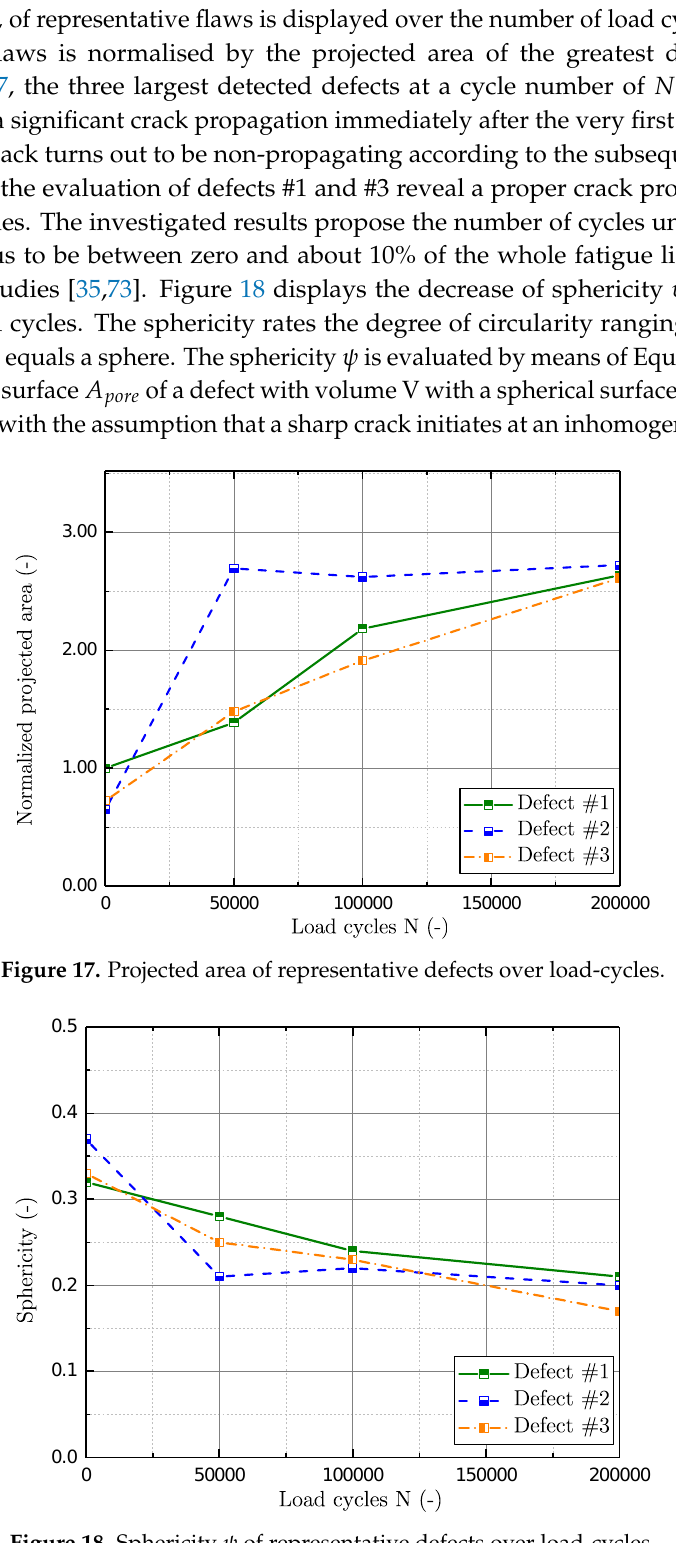
Figure 18. Sphericity ψ of representative defects over